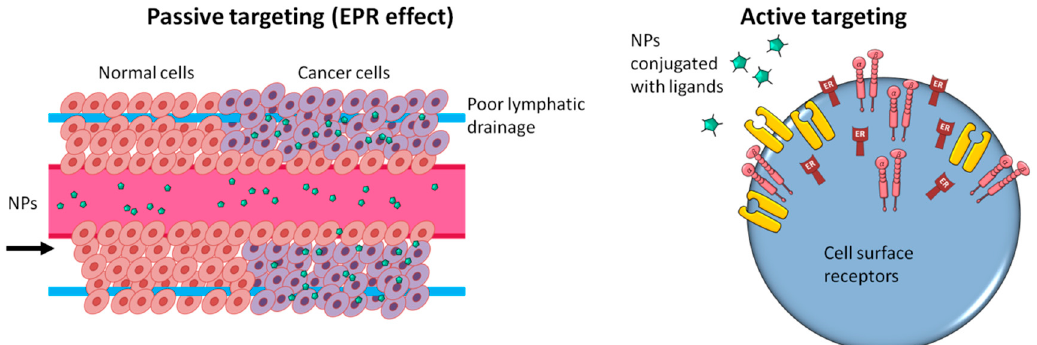
Figure 2. Medical NPs deliver via passive targeting or active targeting mechanisms. Two types of delivery systems are applied in drug delivery. One is a passive targeting system that does not differentiate between targeted cells and normal cells. The other is the active targeting system that delivers drugs specifically to the targeted cells based on cell surface receptors or biomarkers.